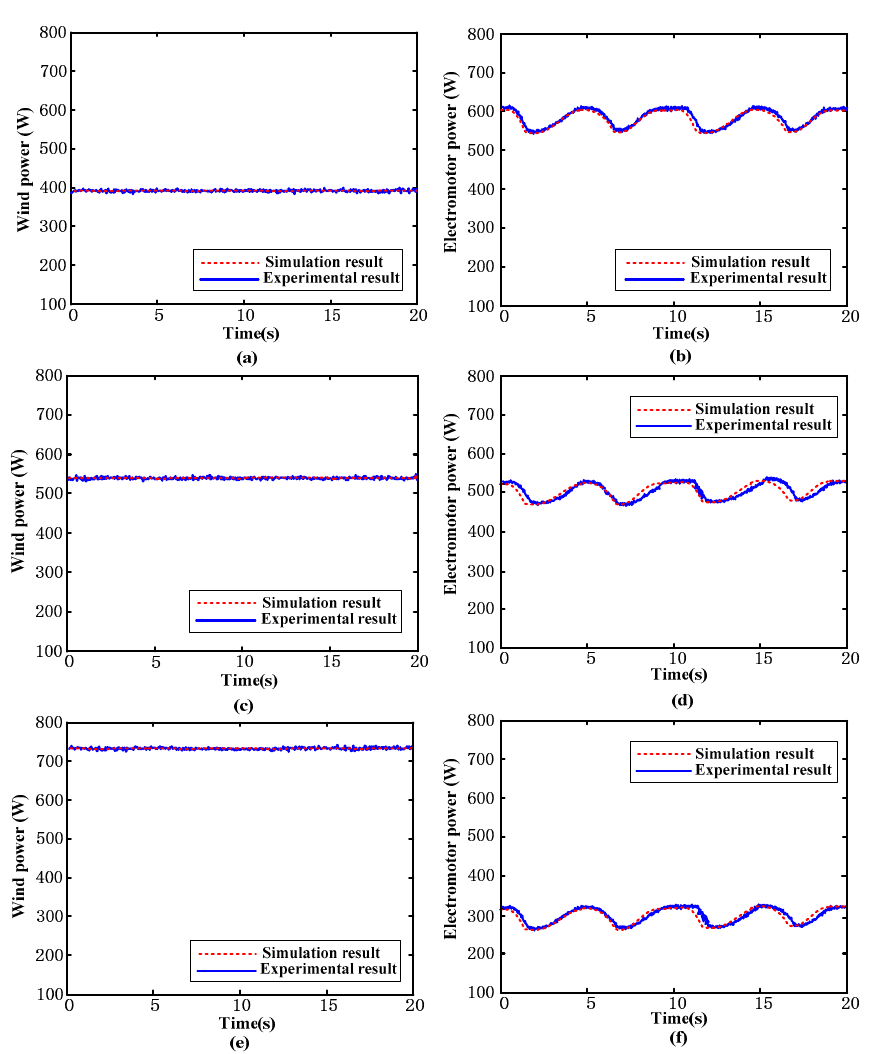
Figure 8. Simulation and experimental comparison curve under different wind speeds. ( a , b ) Wind speed is 9 m / s; ( c , d ) wind speed is 10 m / s; and ( e , f ) wind speed is 11 m / s.